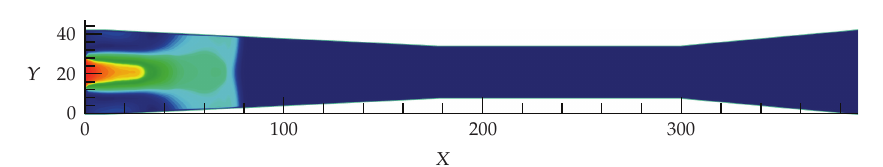
Figure 17: Mach number through the di ff user section at 0.2s.